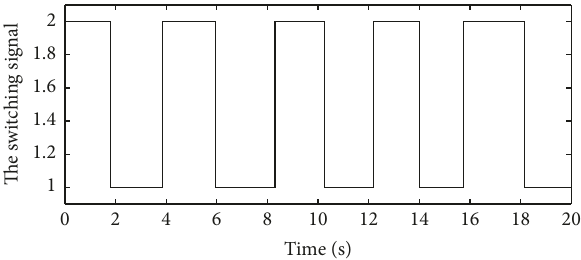
Figure 4: The switching signal for switching topologies.